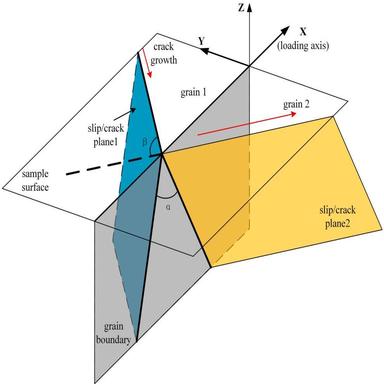
Schematic diagram of the interaction between the slip plane in neighbouring grans.